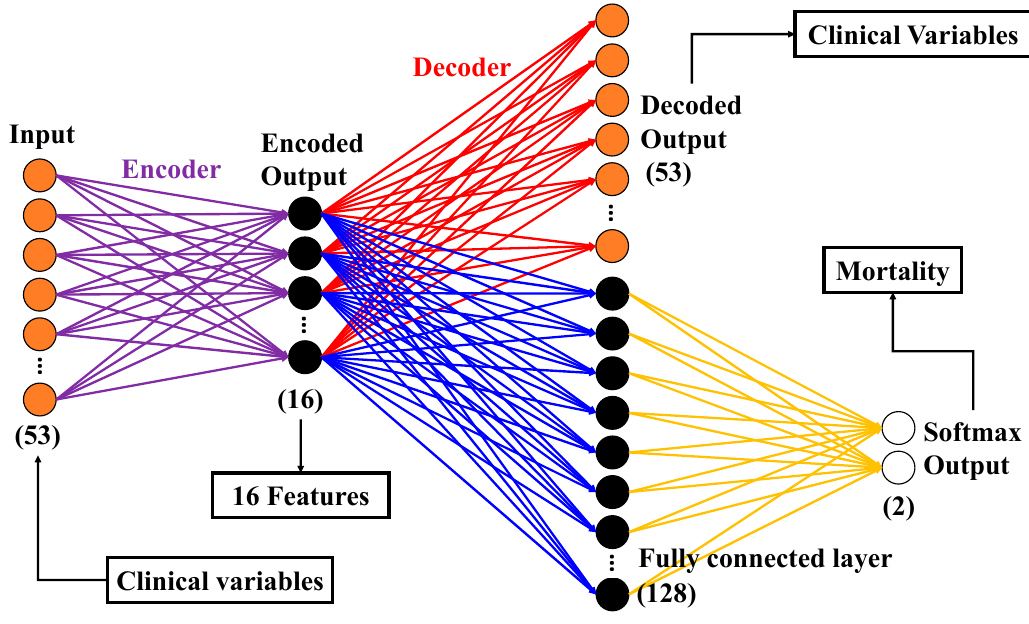
Figure 1. Structure of the autoencoder (AE) in this experiment. Before every activation function,